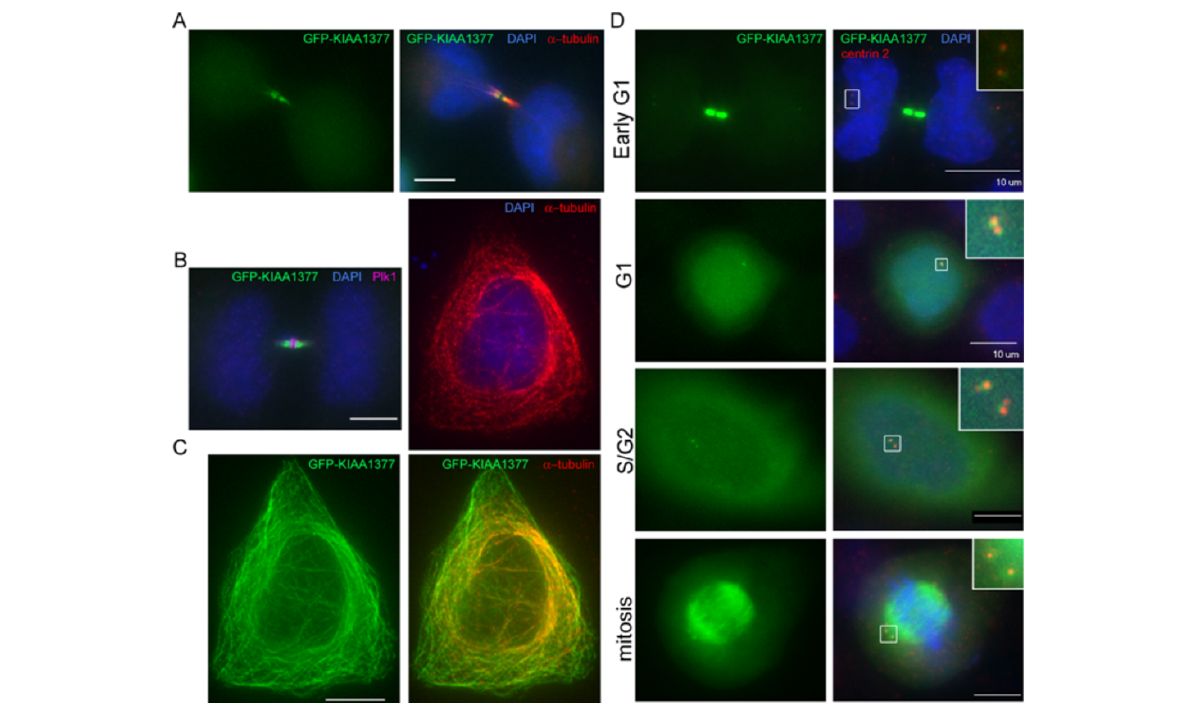
Figure 3 Subcellular localization of GFP-KIAA1377. HeLa cells transfected with GFP-KIAA1377 (green) were fixed and probed with immunofluorescence. Images at single focal planes are shown. Bar=10 μ m. ( A & B ) Transfected cells finishing cytokinesis were co-stained with anti- α -tubulin (red in A) or anti-Plk1 antibody (purple in B) and counter-stained with DAPI for DNA (blue). ( C ) A transfected cell expressing higher level of GFP-KIAA1377 (green) was co-stained for α -tubulin (red) and DNA (blue) to indicate co-localization of GFP-KIAA1377 with microtubule structures. ( D ) GFP-KIAA1377 is localized at centrosomes. Cells at different stages of cell cycle are distinguished based on anti-centrin 2 (red) and DAPI (blue) staining. The GFP signals in different cells were adjusted to the same scale. Enlarged insets show details of boxed